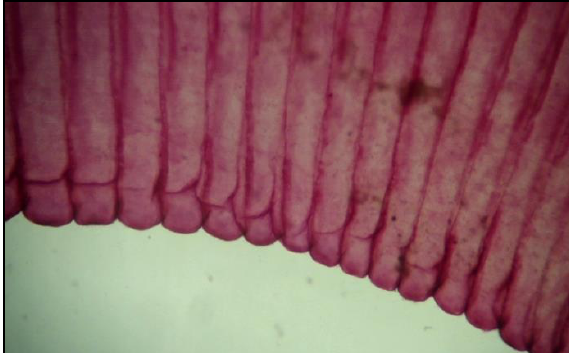
Figure, 4: Microscopic view of the larval stage (cysticercus shows the segmented parts without internal organs (Carmin stain x400).